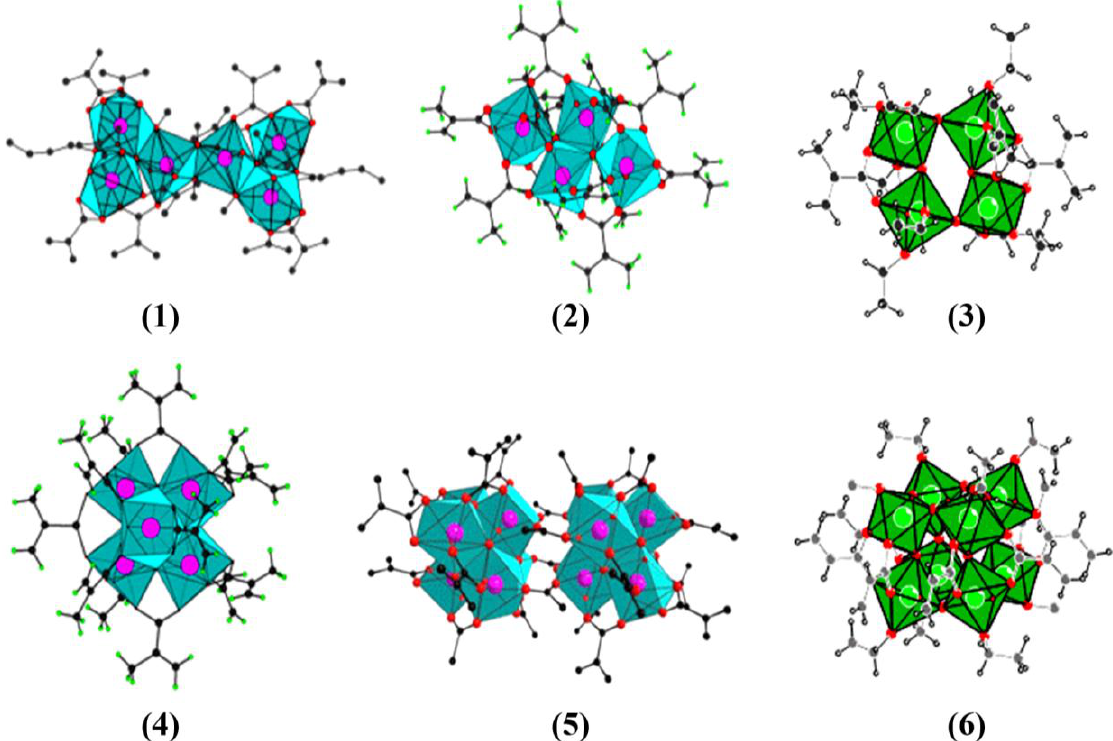
O (OEt) (OMc) [183]; ( 4 ) Zr 4 4 8 4 O (OEt) (OAcr) 8 12 8 8